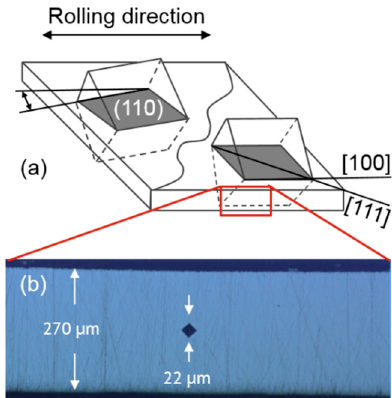
Figure 1. Schematic grain structure of the Goss texture longitudinal to the rolling direction ( a ) and the cyclic hardness indentation ( b ) of investigated electrical steel sheet.